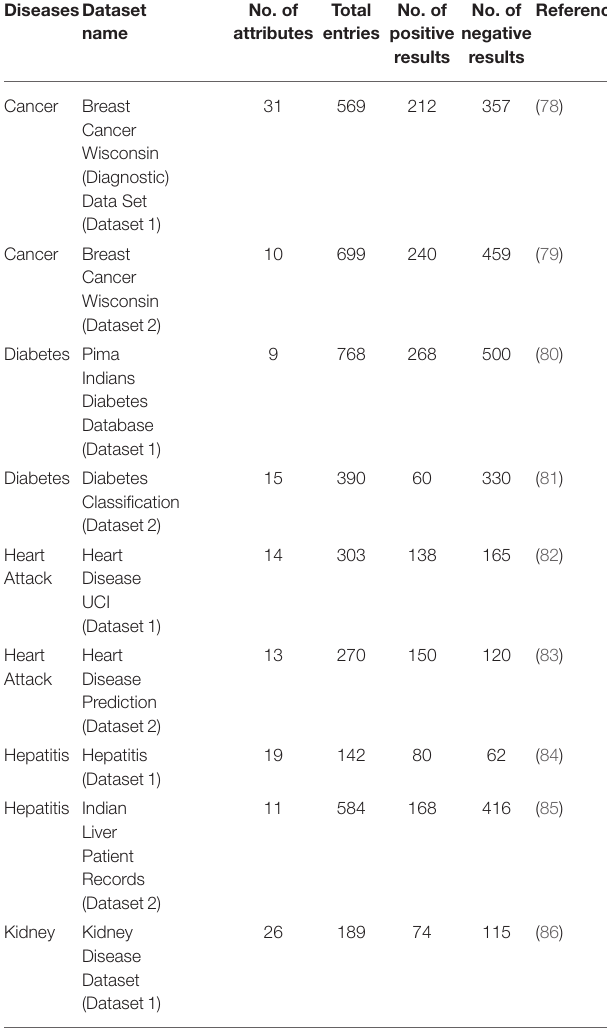
TABLE 2 | Datasets used for classification. DiseasesDataset